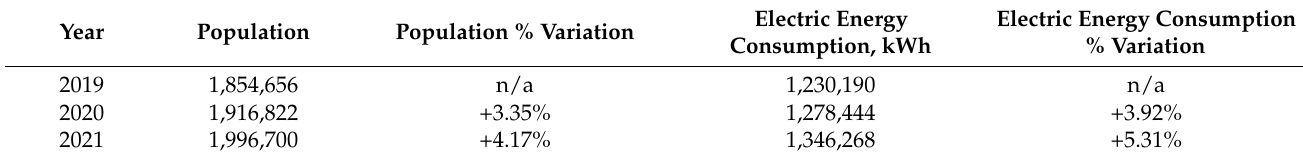
Table 3. Population dynamics and energy consumption change through 2019–2021 in Almaty city.